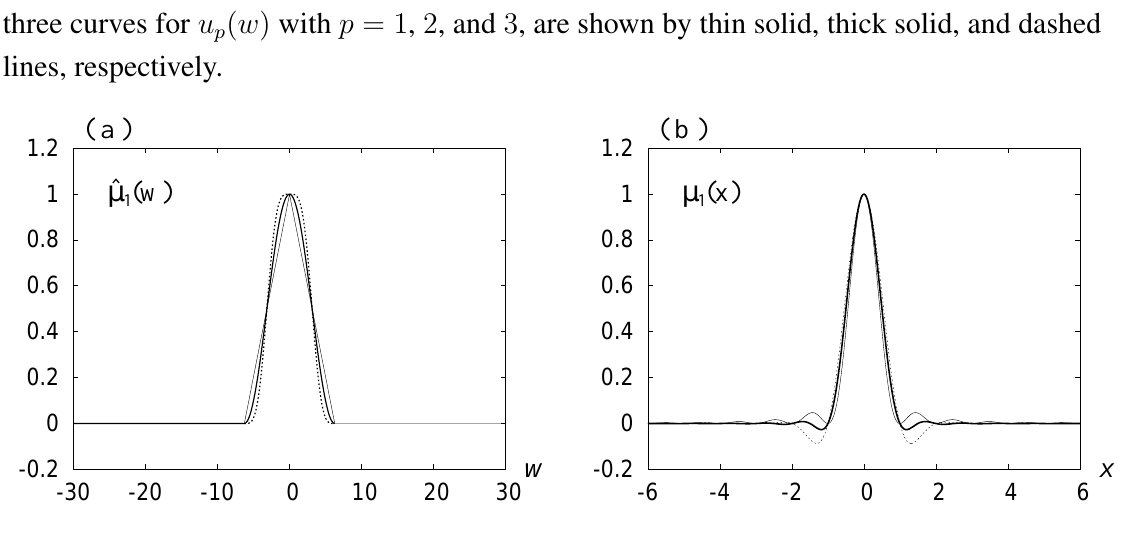
f ( x ) for the mollifiers based on the rdH-wavelet with l = 1 , and ( b ) those Figure 2. ( a ) M 8 0 based on the scaled B-spline wavelets of order m = 1 , 2 . In ( a ), the three curves for u with p = 1 , 2 , and 3 , are shown by thin solid, thick solid, and dashed lines, respectively. In ( x ) is also drawn both in ( a ) and in ( b ( b ), two curves almost overlap. f 0